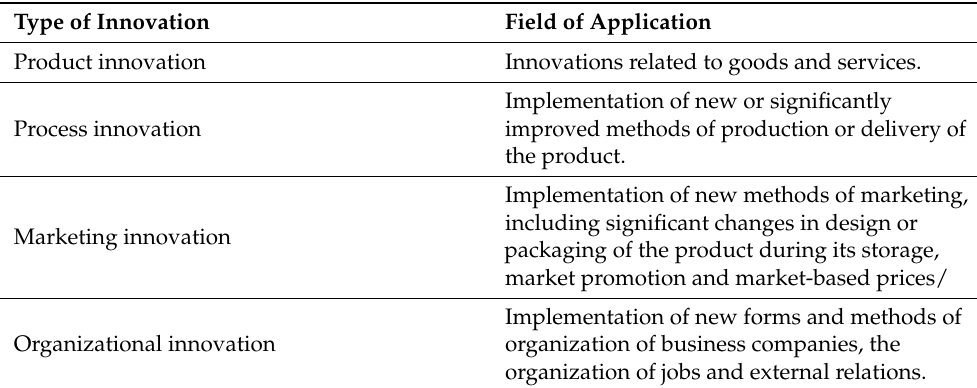
Table 1. Types of innovation identified were classified in accordance with OECD methodology summarized by Kotsemir et al. (2013). Type of Innovation Field of Application Innovations related to goods and